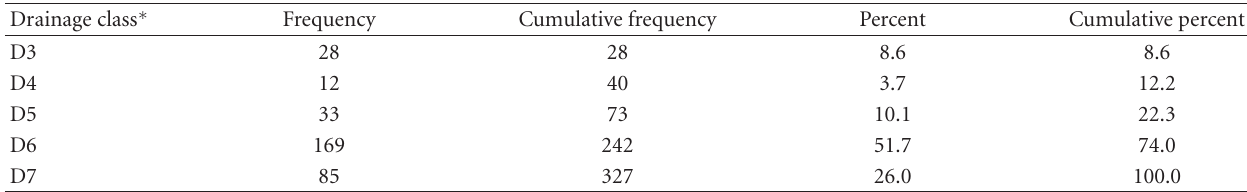
Table 1: Distribution of selected soil profiles of the Bras d’Henri watershed dataset according to the drainage classification from soil survey information.